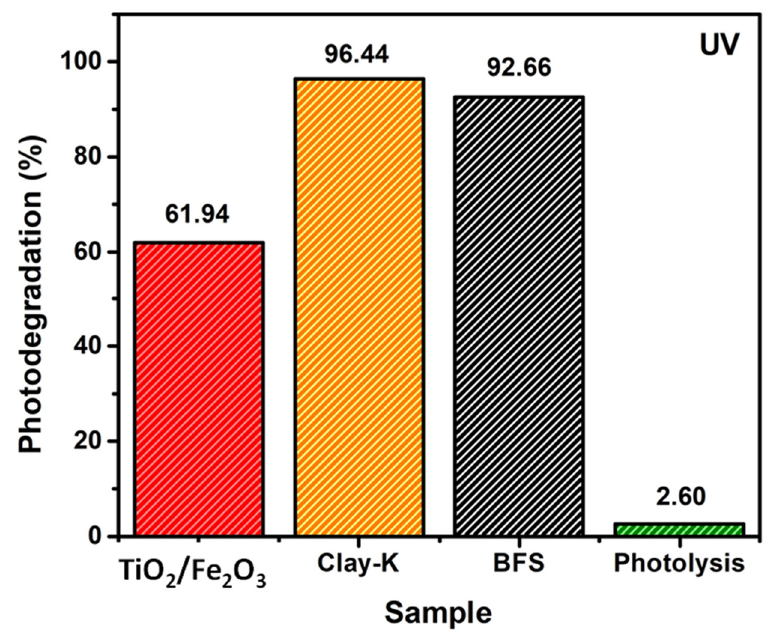
Figure 9. Percentages of cyanide photodegradation with Clay-K, BFS, and Fe 2 O 3 /TiO 2 materials using UV irradiation for 2 h. Initial concentration of NaCN of 750 mg/L. The high percentages of cyanide photodegradation with the Clay-K and BFS indicate that these two catalysts are excited under UV irradiation efficiently, generating electron- hole pairs without recombining, to give rise to the formation of oxidizing species which react with the cyanide oxidizing them, as is showed schematically in Figure 10.